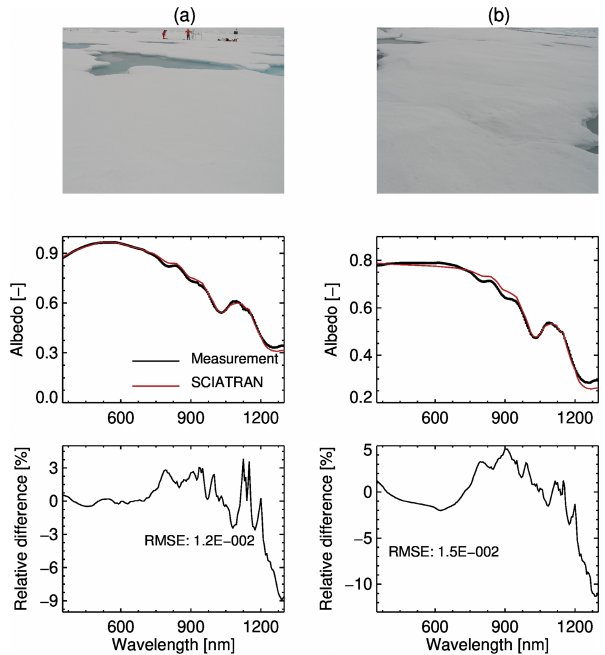
Figure 6. Comparisons of measured and simulated bright white ice spectral albedo corresponding to Fig. 8a and c in Malinka et al. (2016). The upper row shows pictures of the measurement condi- tions, the middle row shows the measured and simulated spectral albedo, and the lower row shows the percentage difference between SCIATRAN simulations and campaign